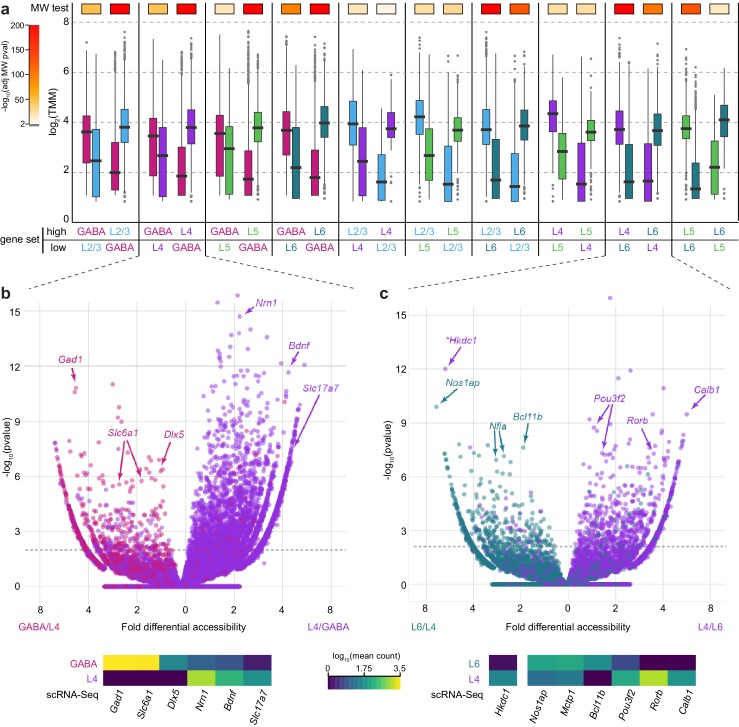
Chromatin accessibility corresponds to cell class-specific transcription.(a) For each pair of cell classes, we identified differentially expressed genes (adjusted p-value < 0.05 and fold change > 2), then separated genes into two groups based on the class with higher expression. We then asked if the peaks that are positionally associated with each group of genes had higher accessibility in the class with higher gene expression. For each peak set, box plots show the median accessibility (black bar), quartiles (boxes), 1.5 × interquartile range (whiskers), and outliers (points). The two distributions of peak accessibility scores for each gene set were compared using a Mann-Whitney U test (MW test). Adjusted p-values are displayed using heatmap boxes above each gene set. (b, c) Two example volcano plots for pairwise comparisons between GABAergic and L4 cells (b) and L4 and L6 cells (c) showing all peaks associated with differentially-expressed genes (adjusted p-value < 1×10–6) . Peaks associated with select marker genes are labeled, and the corresponding average gene expression for these genes from single-cell RNA-seq data for each cell class is shown below. *, Hkdc1-associated peak is more accessible in L6 cell class, although expression of Hkdc1 is greater in L4 class.DOI:
http://dx.doi.org/10.7554/eLife.21883.01610.7554/eLife.21883.017Figure 4—source data 1.Peak accessibility scores (TMM) for peaks associated with gene sets in Figure 4A.DOI:
http://dx.doi.org/10.7554/eLife.21883.01710.7554/eLife.21883.018Figure 4—source data 2.Mann-Whitney test results for each comparison in Figure 4A.DOI:
http://dx.doi.org/10.7554/eLife.21883.01810.7554/eLife.21883.019Figure 4—source data 3.Gene expression data for the heatmap at the bottom of Figure 4B.DOI:
http://dx.doi.org/10.7554/eLife.21883.01910.7554/eLife.21883.020Figure 4—source data 4.Differential accessibility and –log10(pvalue) scores used to generate the volcano plot in Figure 4B.DOI:
http://dx.doi.org/10.7554/eLife.21883.02010.7554/eLife.21883.021Figure 4—source data 5.Gene expression data for the heatmap at the bottom of Figure 4C.DOI:
http://dx.doi.org/10.7554/eLife.21883.02110.7554/eLife.21883.022Figure 4—source data 6.Differential accessibility and –log10(pvalue) scores used to generate the volcano plot in Figure 4C.